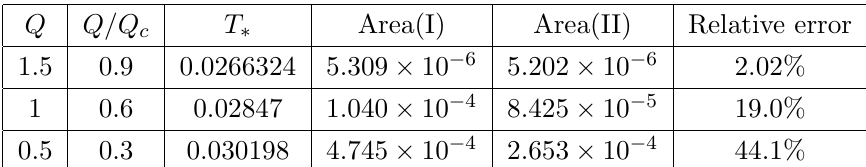
Figure 4 . Charge dependence of T (cid:0) S E diagrams. The plots are displayed for the d = 4 charged ADS black holes, with l = 10, (cid:18) 0 = 0 : 15, and (cid:18) c = 0 : 149. The phase transition temperature T (cid:3) is plotted in red in each case.